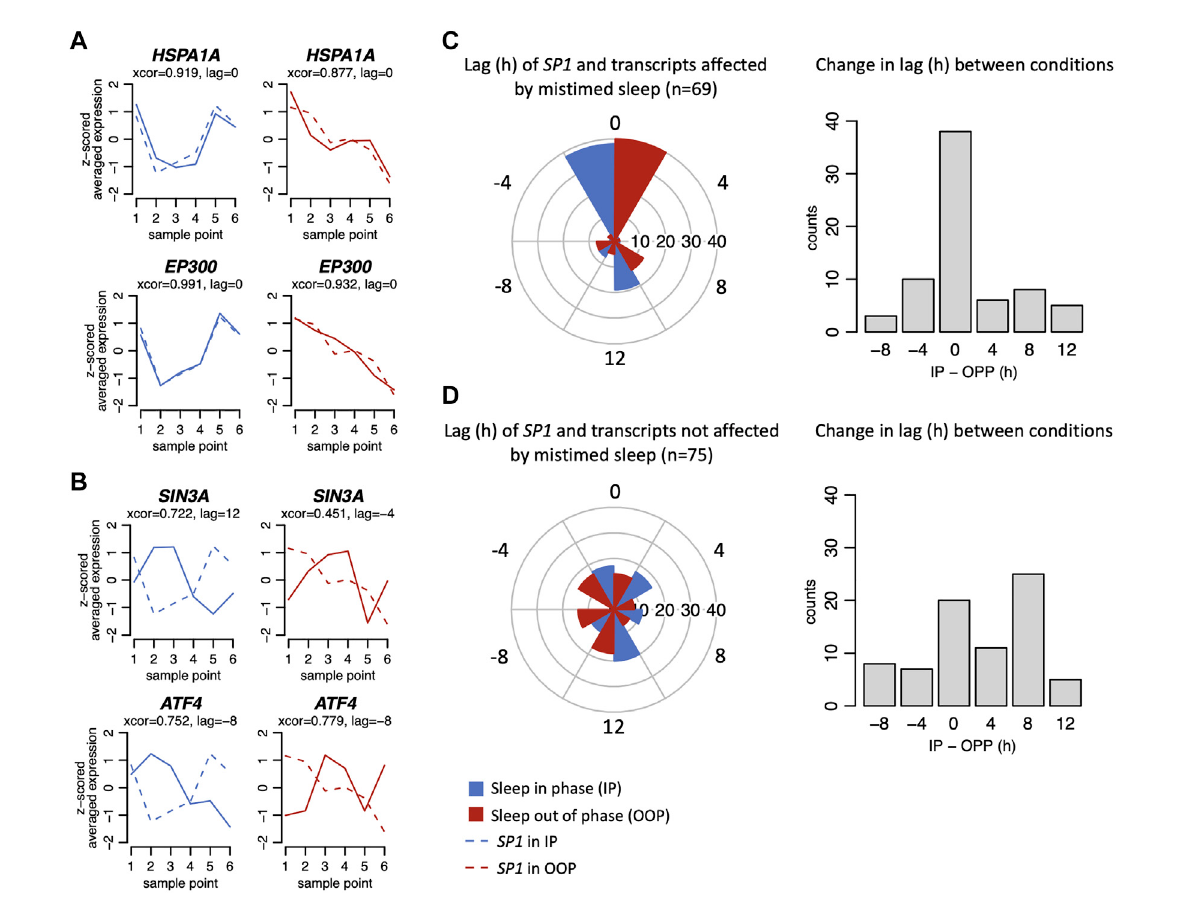
FIGURE 6 Example plots of expression pro fi les (z-scored) when in-phase (blue) and out-of-phase (red) for glucocorticoid signalling transcripts affected (A) and not affected (B) by mistimed sleep. Example plots (solid lines) are shown overlying plots for SP1 (dashed lines). For each plot, the results from the circular cross-correlation analysis are provided with the lag value indicating the timing difference between the example transcript and SP1 . (C) Left. Polar plots show the lag in hours SP1 and transcripts affected by mistimed sleep when sleep occurred in-phase (IP) and out-of-phase (OOP), and on the right, the difference of those lag values between IP and OOP sleep conditions. (D) As for (C) , but for signalling transcripts not affected by mistimed